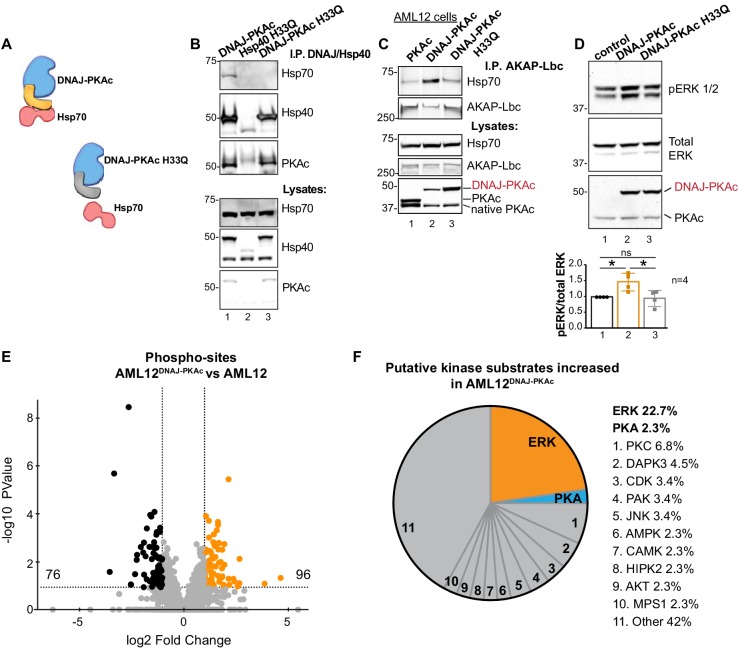
Interruption of the DNAJ-PKAc/Hsp70 interface reduces ERK activation: substrate bias towards ERK signaling in AML12DNAJ-PKAc cells.(A) Schematics of native DNAJ-PKAc (left) and DNAJ-PKAc H33Q mutant that cannot bind Hsp70 (right, gray). (B) Mutation of the chaperonin-binding site (H33Q) on DNAJ-PKAc abrogates interaction with Hsp70. Endogenous HSP70 co-precipitates with DNAJ-PKAc in AML12 cells expressing FLAG-DNAJ-PKAc (lane 1), but not with FLAG-Hsp40 H33Q control (lane 2) or the FLAG-DNAJ-PKAc H33Q mutant (lane 3). (C) GFP-tagged AKAP-Lbc co-precipitates endogenous Hsp70 in AML12 cells expressing FLAG-DNAJ-PKAc (lane 2) but not in cells expressing the wildtype FLAG-PKAc (lane 1) or the FLAG-DNAJ-PKAc H33Q mutant (lane 3). (D) Immunoblot detection of phospho-ERK1/2 in AML12 cells transiently transfected with DNAJ-PKAc (lane 2) or DNAJ-PKAc H33Q (lane 3). Total ERK (middle) served as a loading control. Detection of PKAc (bottom) monitored transfection efficiency. Quantitation of blots from four experiments, p=0.01 (t = 3.406, df = 6) and p=0.03 (t = 2.758, df = 6). (E and F) Differential phosphoproteomic profiling of AML12DNAJ-PKAc cells. (E) Volcano plot showing abundance (orange) and reduction (black) of phosphopeptides in AML12DNAJ-PKAc cells. Statistical significance of biological replicates was calculated by Student’s t test with Log10-transformed p-values of individual phosphopeptides plotted against log2-transformed fold change; n = 6. (F) Pie chart of putative kinase substrates increased in AML12DNAJ-PKAc cells. Sites identified by NetworKIN platform. Individual kinases are listed. ‘Other’ kinases include: CK, ABL2, GRK, GSK3, JAK2, NLK, and SRC.